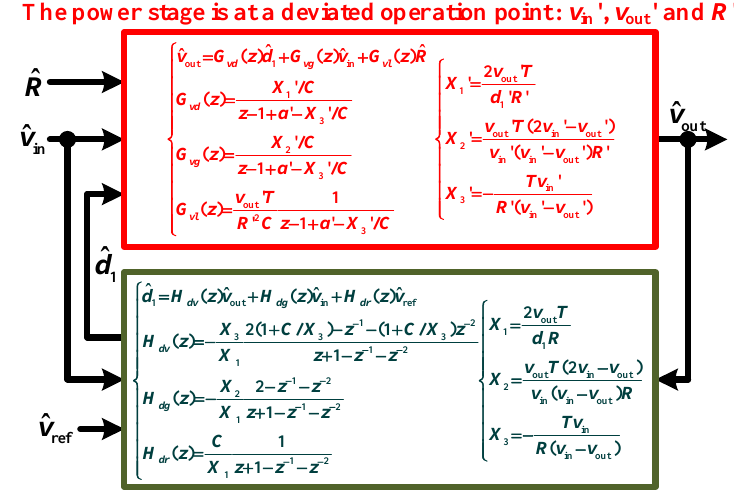
Figure 8. Closed-loop small signal model of the system under deviated operation point.